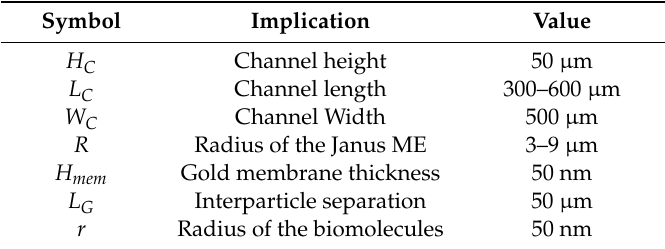
Table 1. Geometric size of the fluidic device shown in Figure